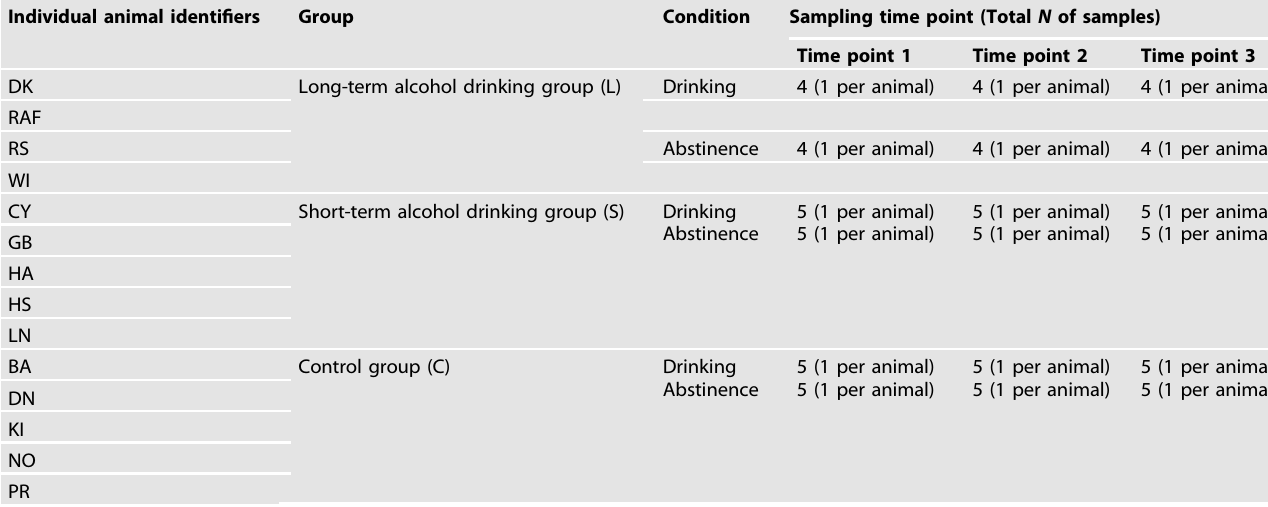
Table 1. Baboons and sampling time points for each group and condition. Individual animal identi fi